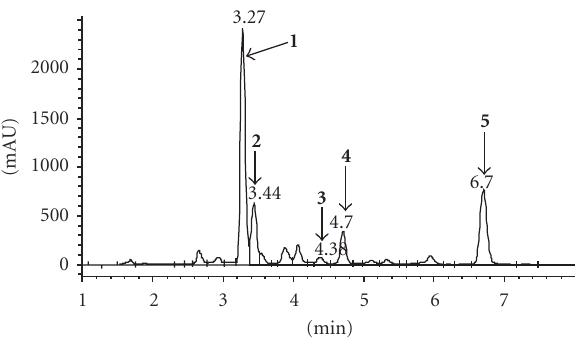
Figure 7: HPLC chromatogram of the mixture of allicin trans- formation products obtained under the e ff ect of microwaves in methanol at 55 ◦ C ((E)-ajoene ( 1 ); (Z)-ajoene ( 2 ); 3-vinyl-4H-1,2- dithiin ( 3 ); 2-vinyl-4H-1,3-dithiin ( 4 ); dialildisulfid ( 5 )).